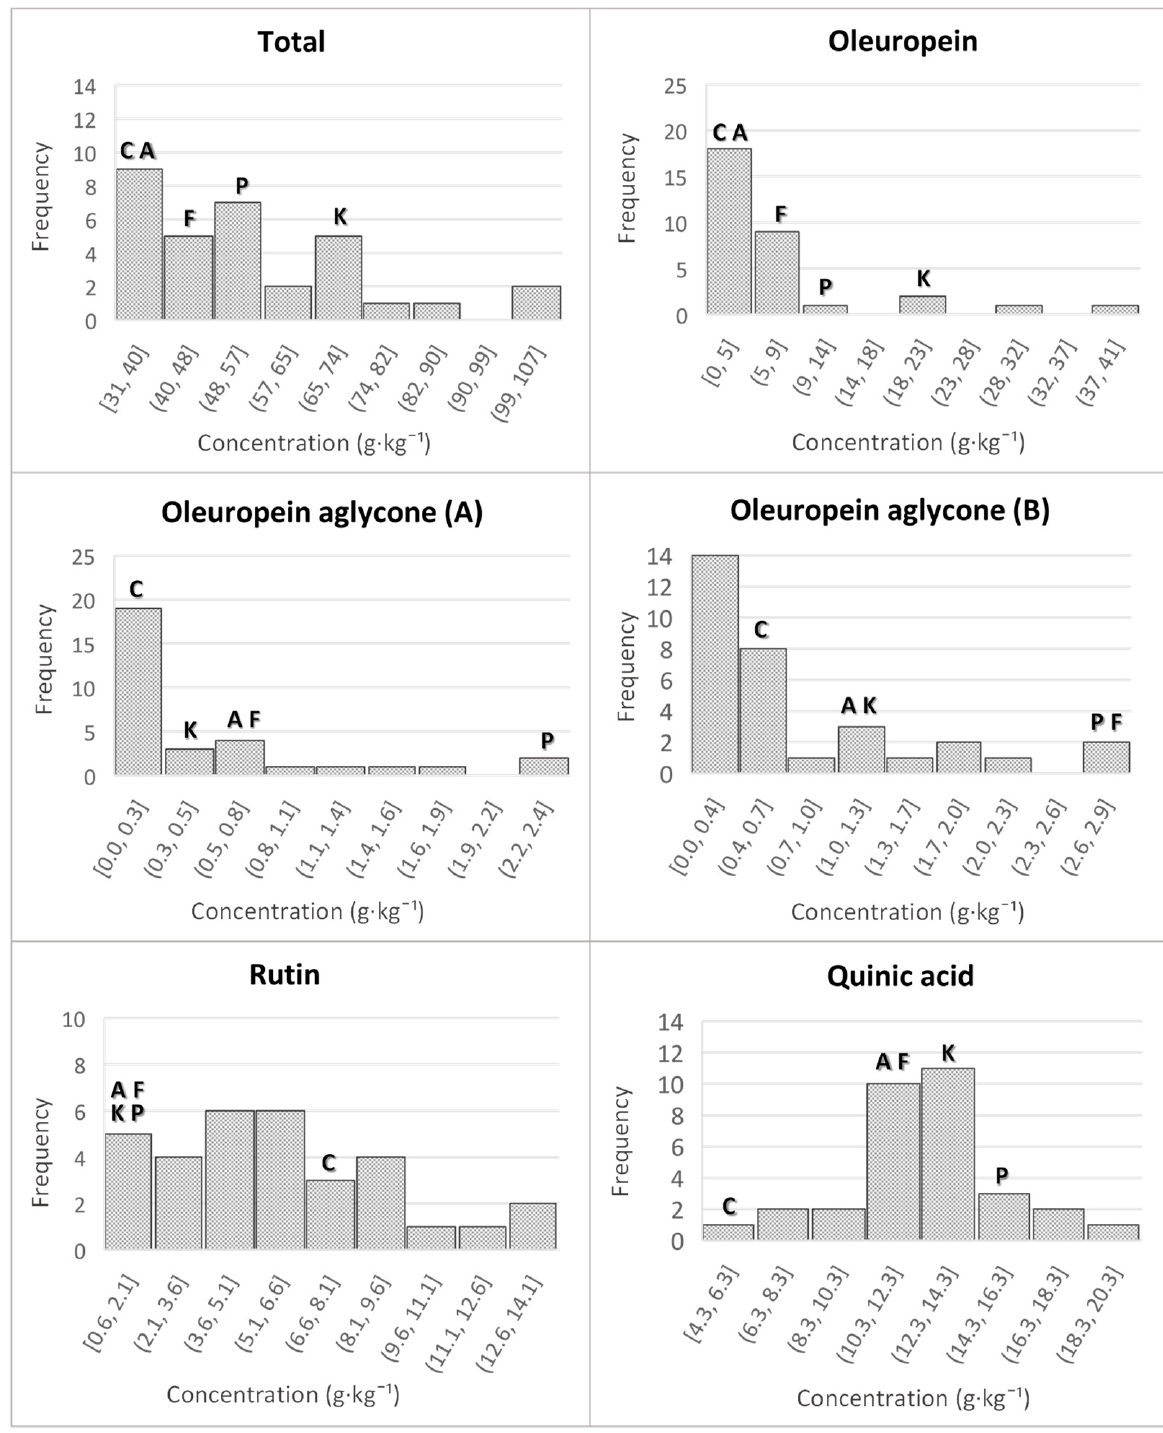
Figure 3. Histograms for total metabolite content and five specific compounds analyzed in the progeny (g · kg − 1 ). The ranges in which the female parent and cultivars fall are indicated with letters as follows: female parent of the open pollination progeny—C; “Arbequina” cultivar—A; “Frantoio” cultivar—F; “Koroneiki” cultivar—K; “Picual”